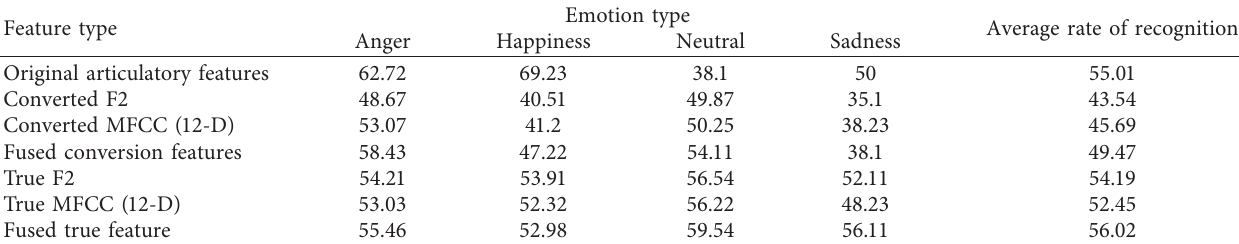
Table 4: Recognition results on bimodal emotional speech database based on different features